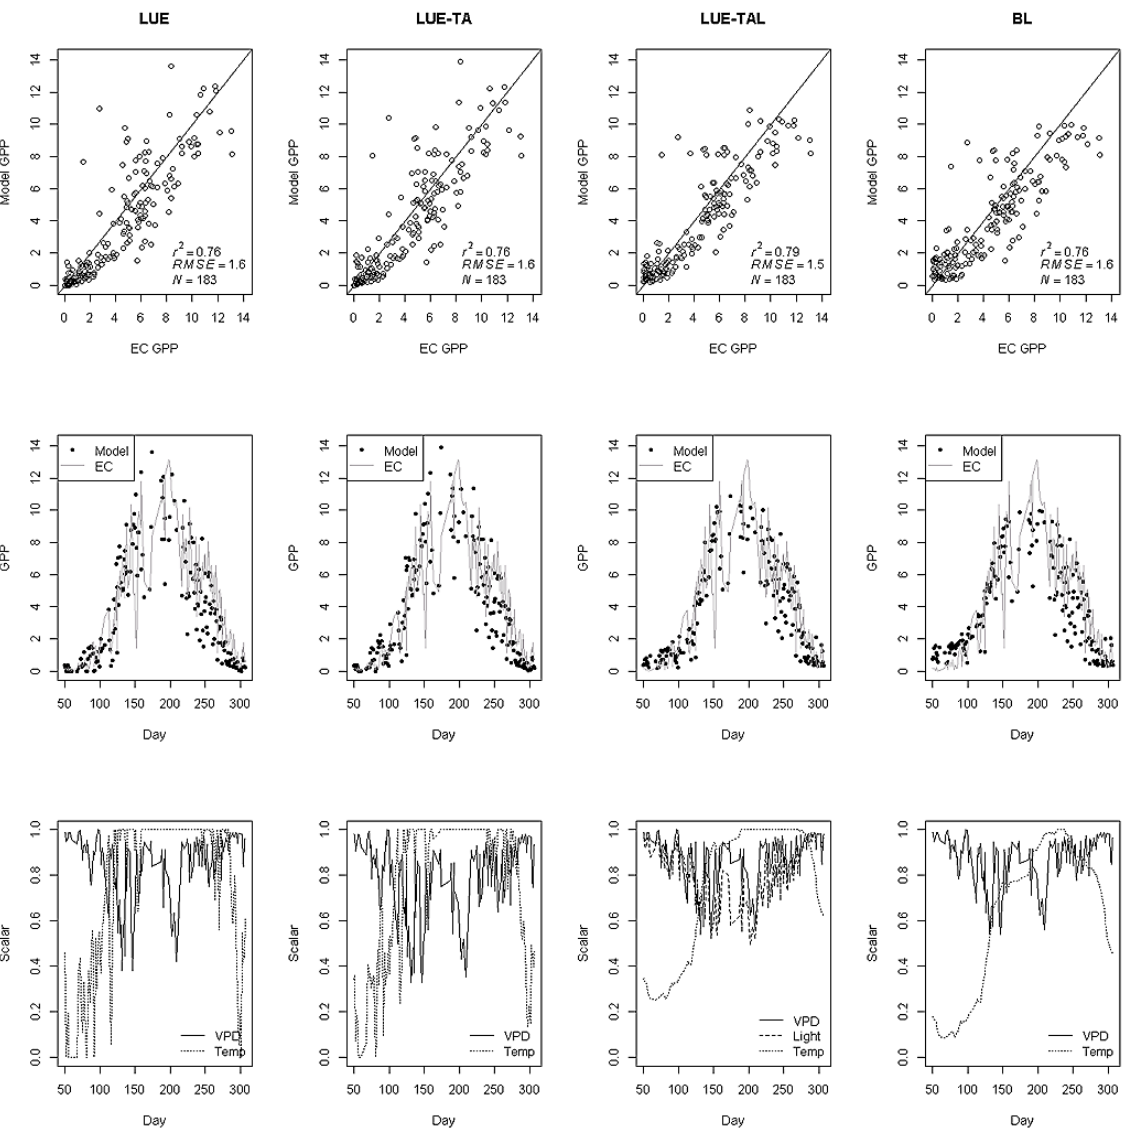
Fig. 3. Results for Fyodorovskoe, 2003, from the LUE (1st column), LUE-TA (2nd column), LUE-TAL (3rd column) and BL (4th column) models where the top row depicts scatter plots of EC GPP vs. model GPP, the middle row depicts the daily course of GPP (EC and model) and the bottom row depicts the environmental scalars for temperature and VPD. GPP in units of gCm − 2 d − 1